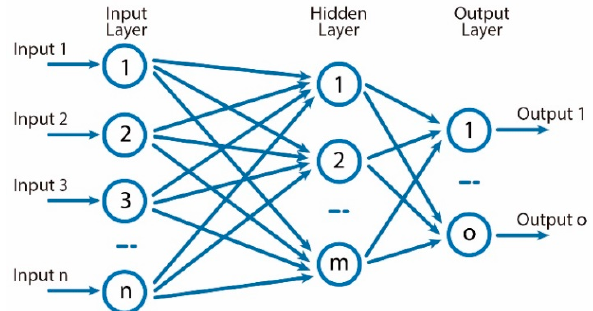
Figure 3. Architecture of a multi-layer neural network.